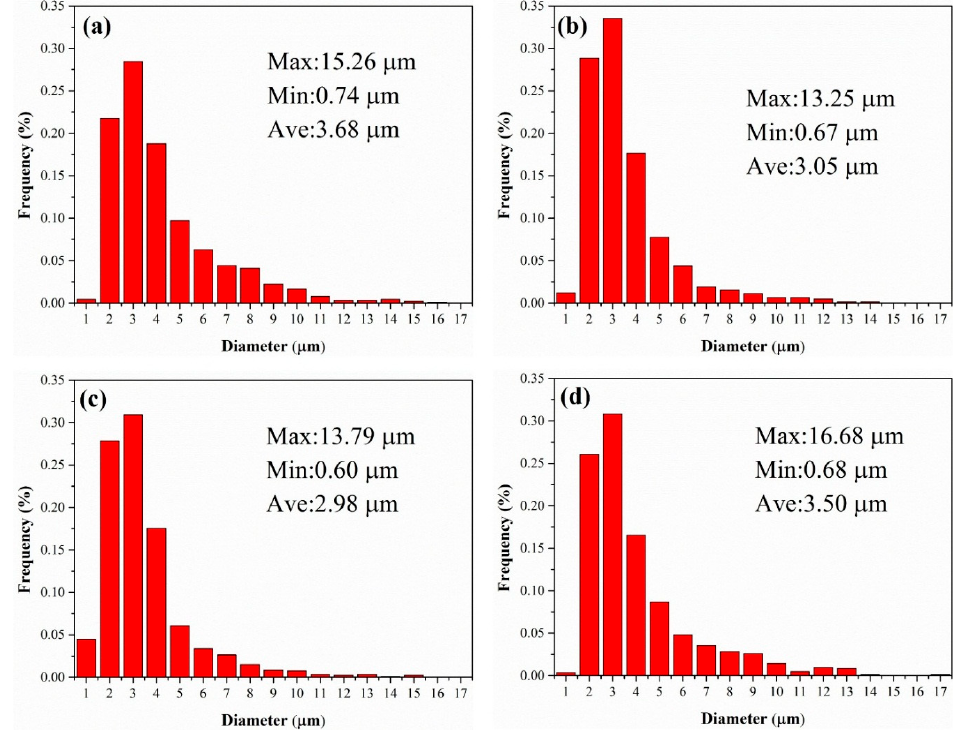
Figure 4. Grain size distribution of the AZ31 and the GNPs/AZ31: ( a ) AZ31, ( b ) 0.5GNPs/AZ31, ( c ) 1.0GNPs/AZ31, and ( d ) 2.0GNPs/AZ31.